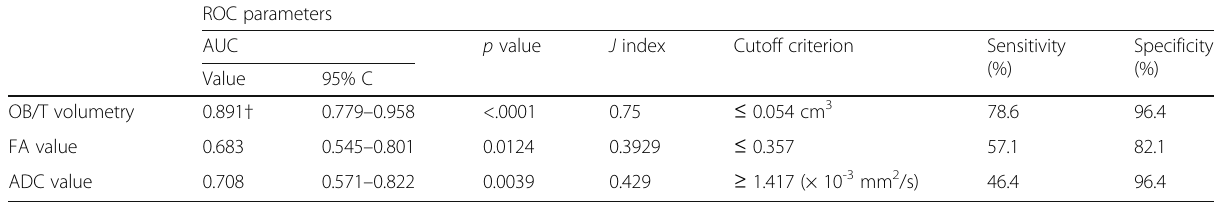
Versus AUC = 0.5 (DeLong method) AUC area under the ROC curve